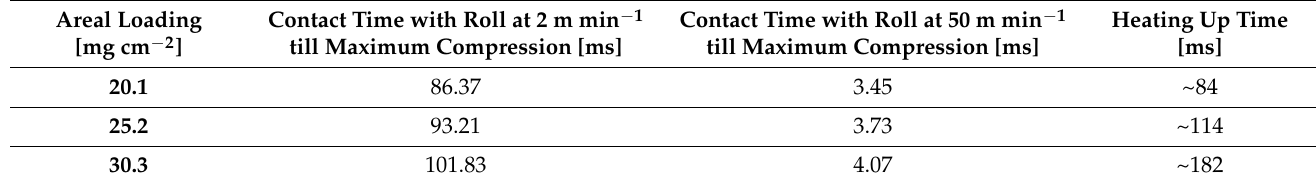
Table 3. Contact times between roll and electrode and the respective heating up times for different areal loadings assuming a line speed of 2 m min − 1 and 50 m min − 1 neglecting the looping of the electrode and the